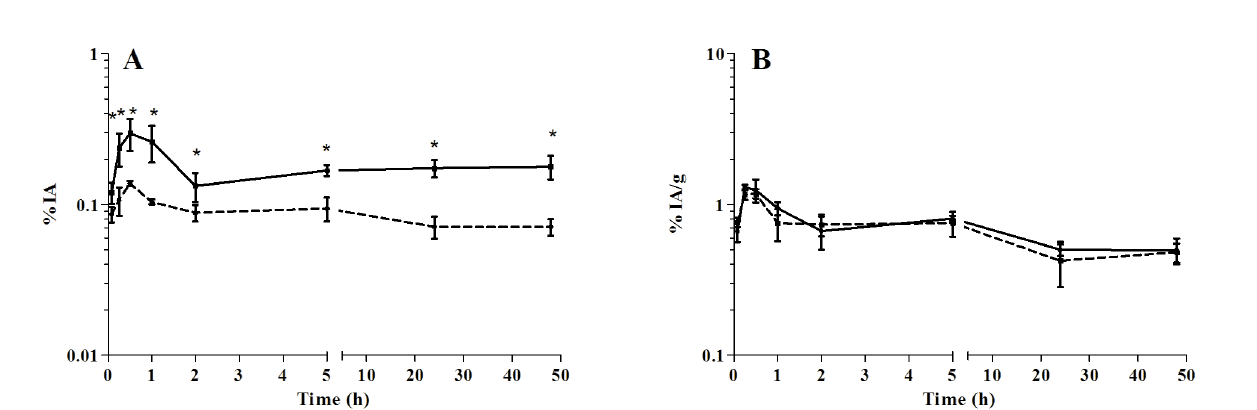
Cmax, peak plasma concentration; Tmax, time to Cmax; t1/2, plasma half-life; E phase, elimination phase; D/A phase, distribution or absorption phase; AUC, area under the concentration-time curve; AUMC, area under the first moment curve; MRT, mean residence time; CL, total clearance. The significance of differences between uninfected and infected mice was calculated by Student’s t test. * p<0.05.